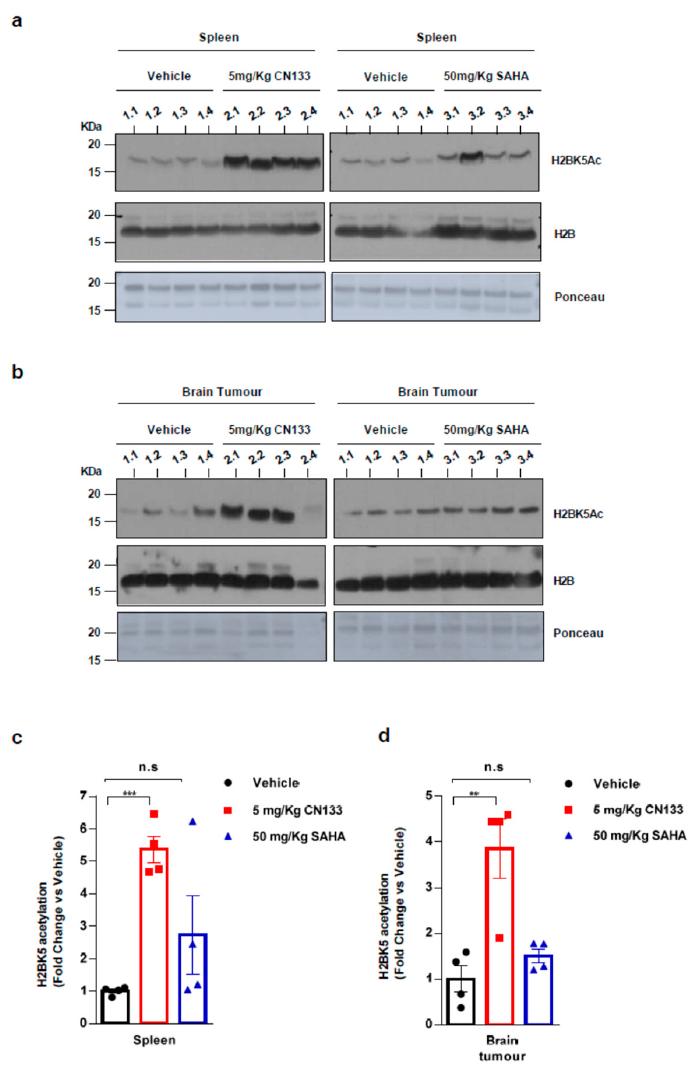
Figure 5. CN133 is more potent than SAHA in increasing histone acetylation in vivo: Western Blot of spleen ( a ) or brain tumors ( b ) from mice treated for 14 days with 5 mg/kg C133 or 50 mg/kg SAHA administered twice a day by i.p. Numbers above the western blots indicate mouse identification. Uncropped Blots of Figure 5a,b are shown in Figure S9 ( c , d ) Densitometry analysis of H2BK5ac levels normalized to H3. Fold changes are relative to values from vehicle-injected mice. ** p < 0.01; *** p < 0.001.